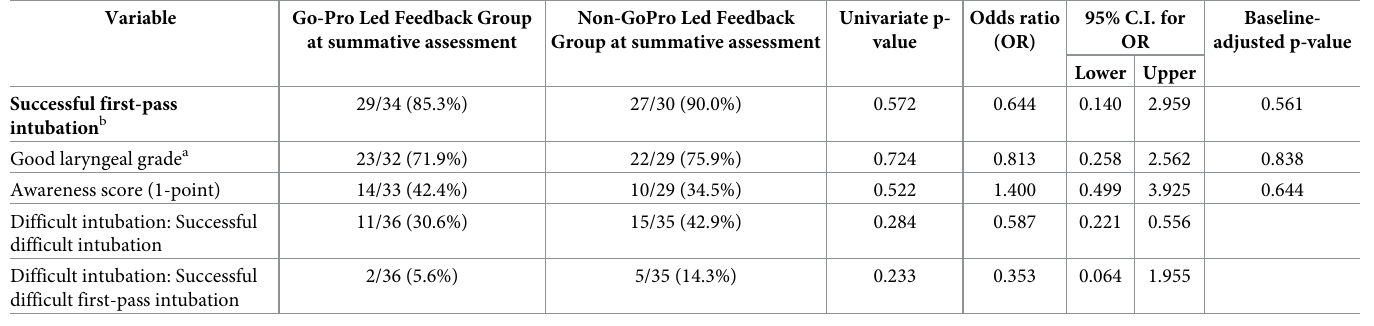
Table 2. Categorical outcomes at summative assessment with univariate and baseline-adjusted analysis. Variable